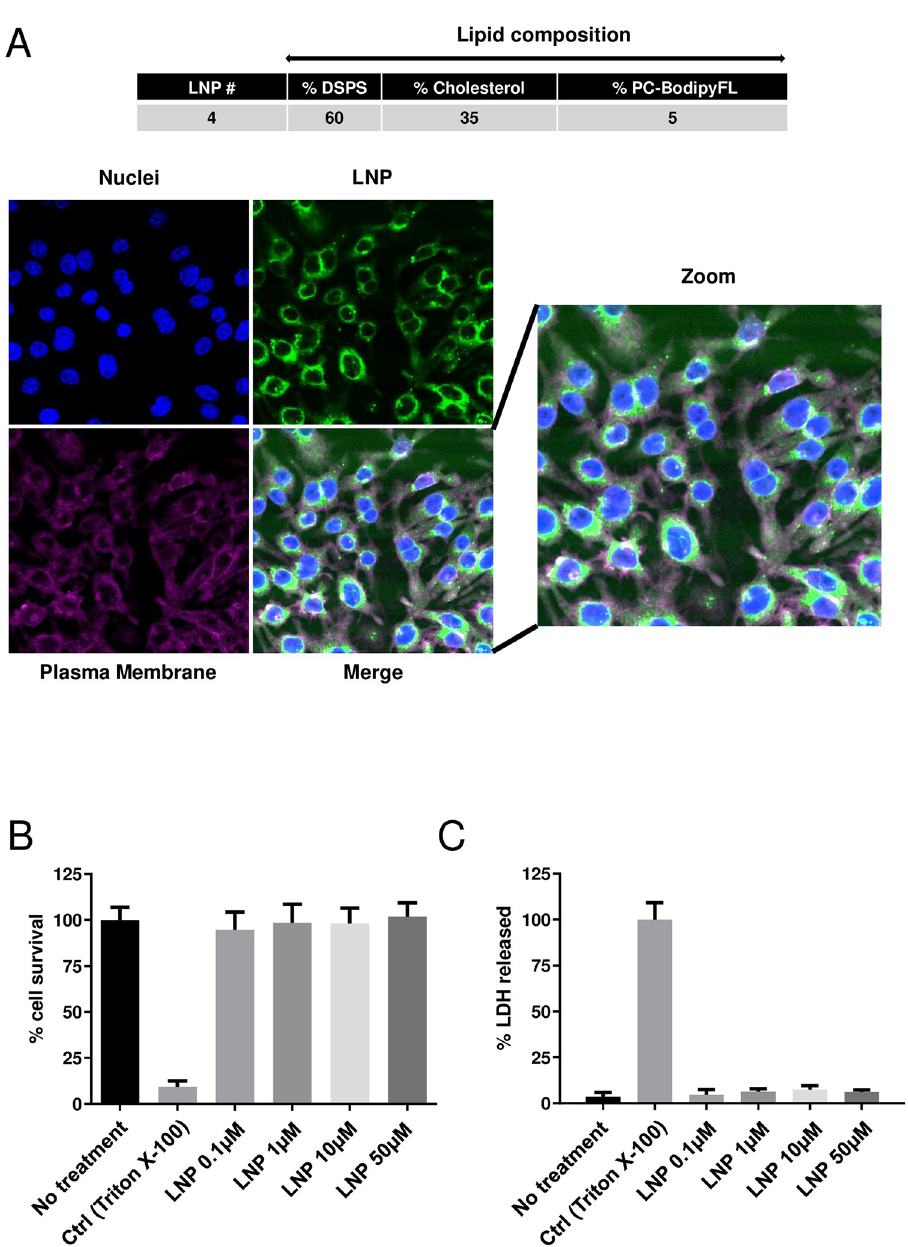
Fig 3. DSPS-LNP can reach the cytoplasm of macrophages without detectable toxicity. (A) RAW264.7 cells (2 × 10 6 ) were treated for 24 h with LNP-S60 at 50 μ M, which contain fluorescent probe Bodipy-FL (green). Cells were then fixed and stained with a fluorescent-labeled WGA coupled with Biotium’s CF 1 640R (magenta) and DAPI (blue). Cells were imaged by confocal microscopy. (B-C) RAW264.7 cells (2 × 10 6 ) were treated with different concentrations of LNP-S60 (0 μ M, 0.1 μ M, 1 μ M, 10 μ M, 50 μ M) or 0.1%Triton X-100 for 72 h, and cell viability was measured by MTT assay (B) or LDH assay (C) . mean ± SD were expressed relative to none-treated group (B) or were expressed relative to the total LDH level obtained from cells treated with 0.1% triton X-100 (C) . The results are representative of two experiments.